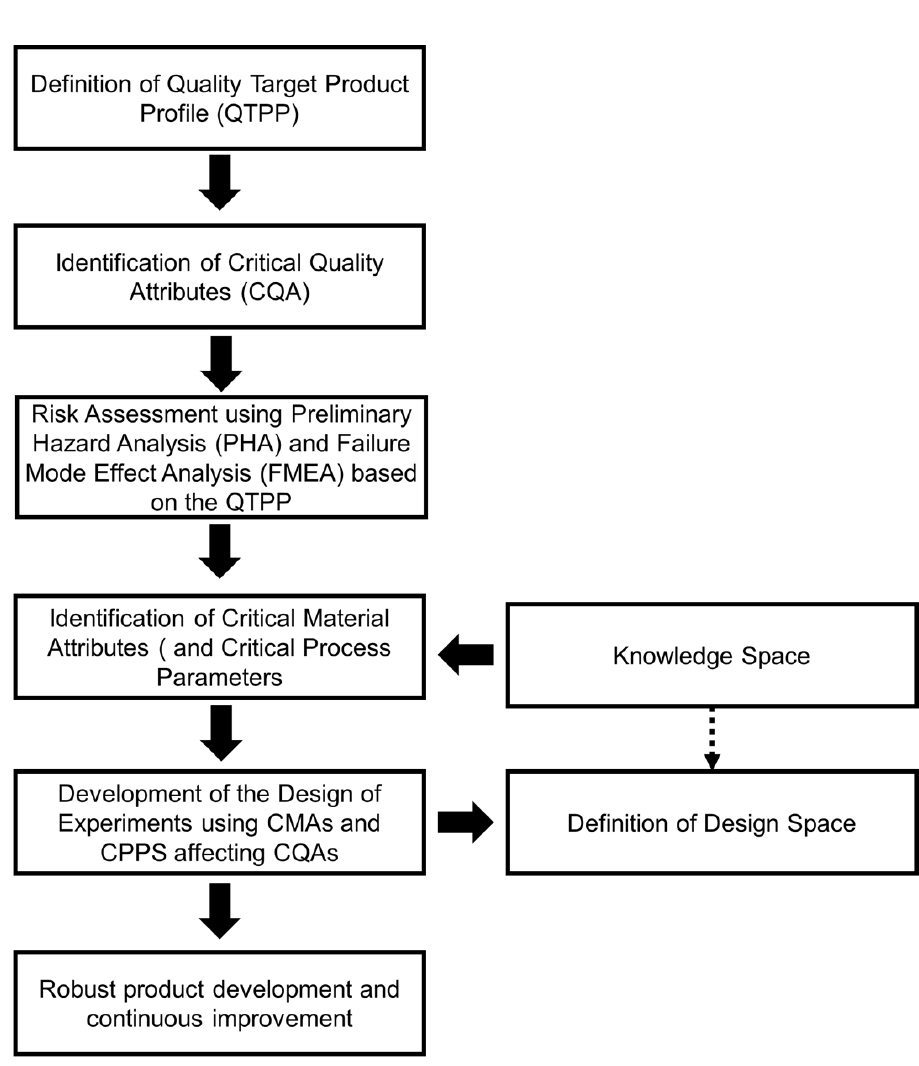
Figure 6. Steps in the development of immediate ‐ release formulas based on a Quality ‐ by ‐ Design